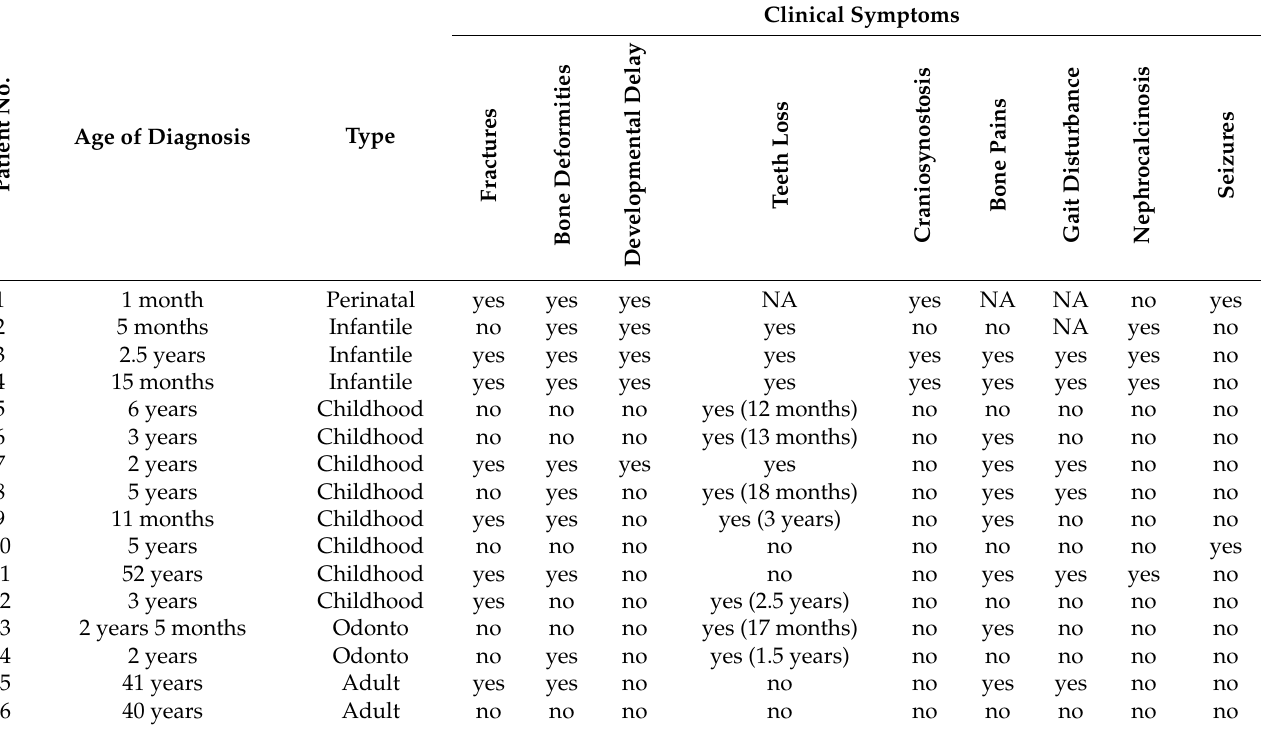
Table 1. Age of diagnosis, type of HPP, and clinical symptoms in the examined